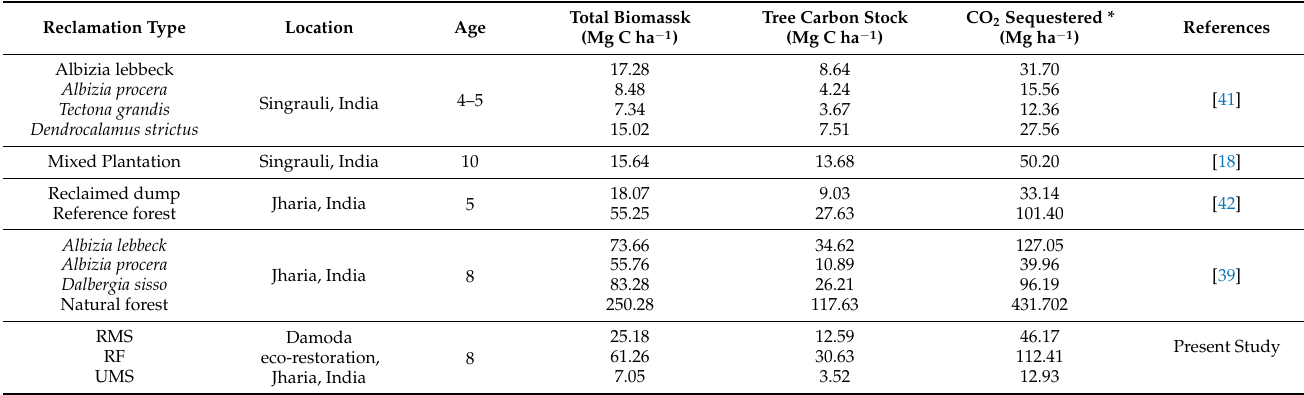
Table 2. Total biomass, tree carbon stock and CO 2 sequestered in various coal mine spoils of the world and their values in the current study (RMS: reclaimed mine spoil and RF: reserve forest).